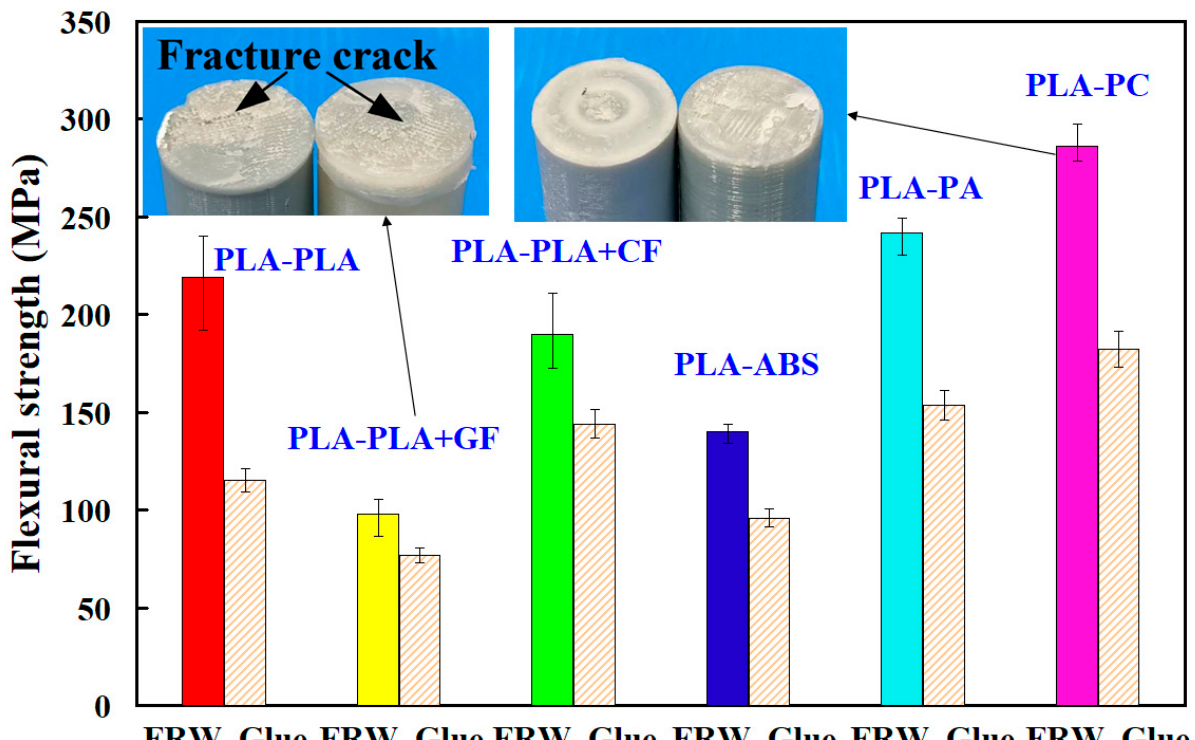
Figure 13. Temperature change rate of three zones in dissimilar joints.